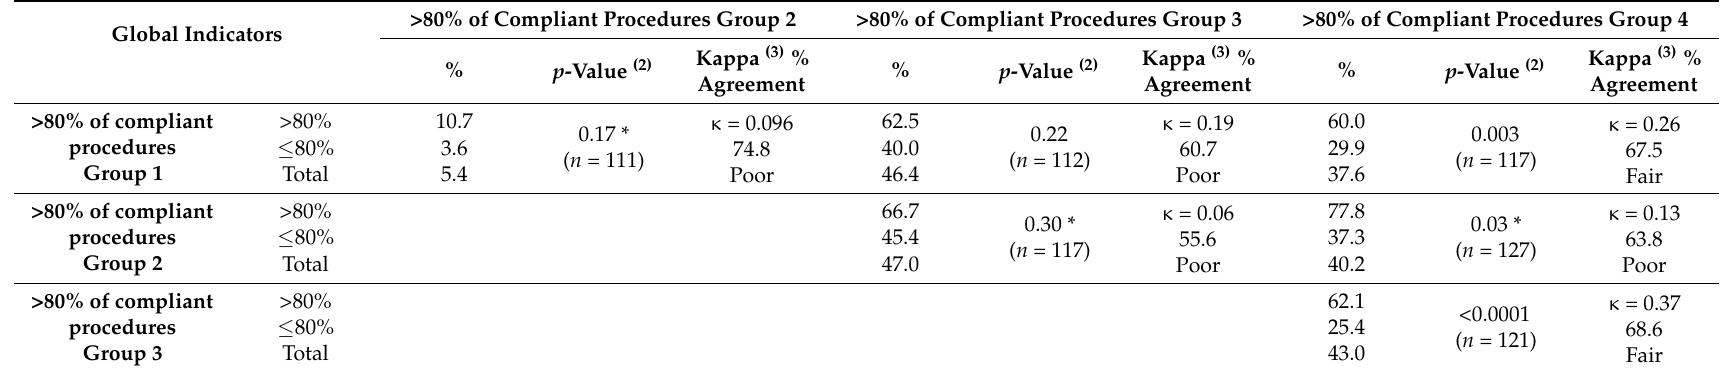
Table 6. Pairwise statistical relationships and levels of agreement between global adherence to procedures (>80%) in the different groups (1) . Global